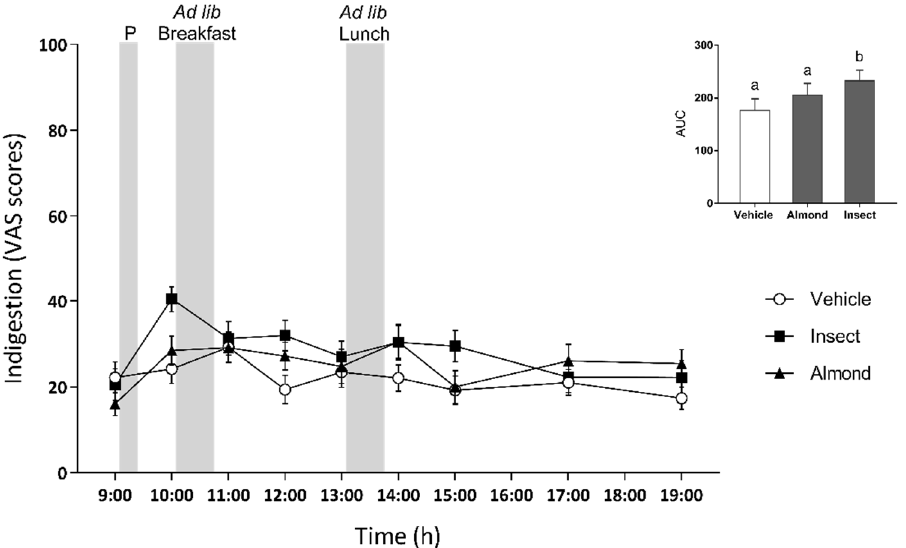
Figure 5. Indigestion ratings during the three test days. Grey bars indicate the time of the preload (P), breakfast, and lunch intake. Data are expressed as mean ± standard error of the mean (SEM). The bar graph represents the mean AUC of each of the three preload groups for the indigestion ratings. Different letters (a,b) indicate significant differences, p < 0.05, (repeated-measures ANOVA followed by Bonferroni adjustment for multiple comparisons).